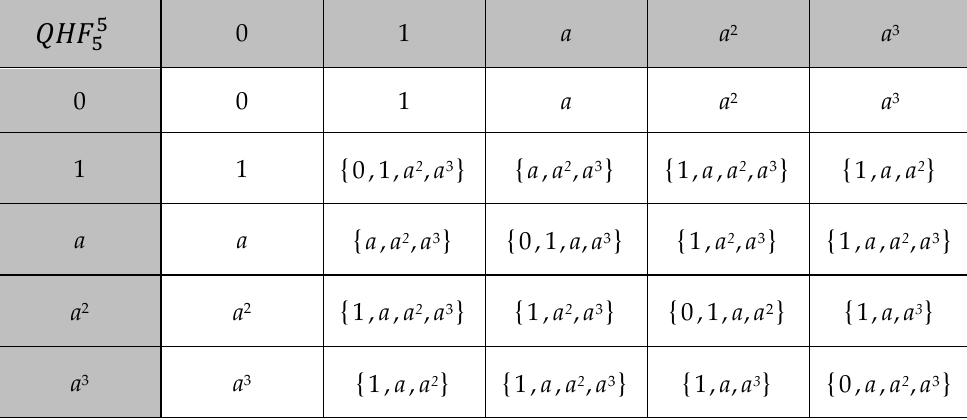
Table 17. The Cayley table of the additive canonical hypergroup of the quotient hyperfield GF [5 2 ]/G, which is also denoted by QHF 5 . GF [5 2 ] / G, which is also denoted by 𝑄𝐻𝐹 55 . 5